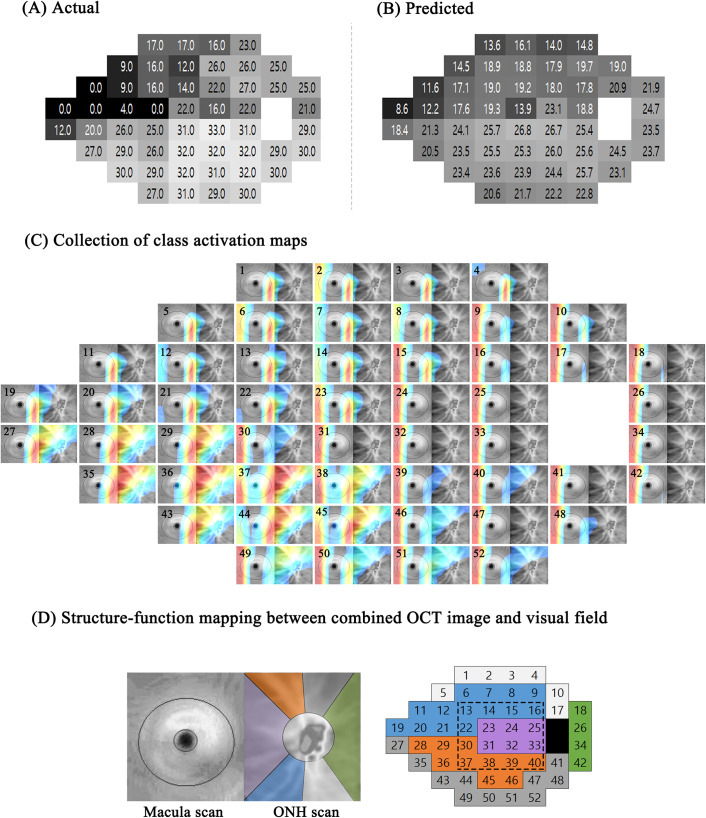
Representative example of Class Activation Map (CAM).The figure shows (A) the actual threshold values and (B) the predicted threshold values of the visual field examination. (C) Fifty-two CAMs were placed at individual visual field test points. Each CAM image is numbered at the top left. (D) Structure-function mapping between the combined OCT image (left) and the visual field (right). The macular scan in the combined OCT image corresponds to the dashed rectangle in the visual field. Color-coded Garway-Heath sectors are superimposed on the ONH scan of the combined OCT image and the corresponding visual field regions are similarly colored. The numbers in the visual field image are the same as those in the CAM images of (C).